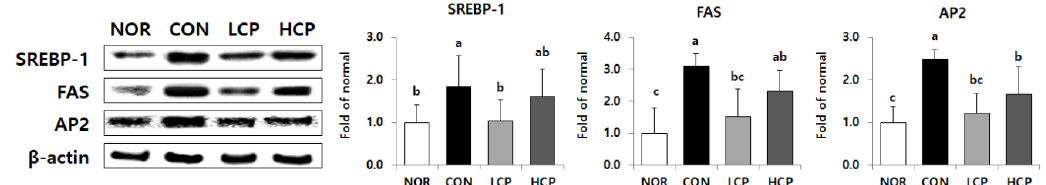
Figure 7. E ff ects of two skate skin-derived collagen peptides with di ff erent molecular weights on protein expression of lipogenesis-related molecules in adipose tissue. Data are mean ± standard deviation (SD) ( n = 10 per group). Experimental groups were divided into four groups; m / m mice were orally administered water as a vehicle (NOR group) whereas db / db mice were orally administered water (control group, CON), LCP (LCP group), or HCP (HCP group) at a dose of 200 mg · kg bw − 1 · day − 1 for 8 weeks. a–c Di ff erent letters mean significant di ff erences to one-way analysis of variance (ANOVA), followed by Duncan’s multiple-range test at p < 0.05.